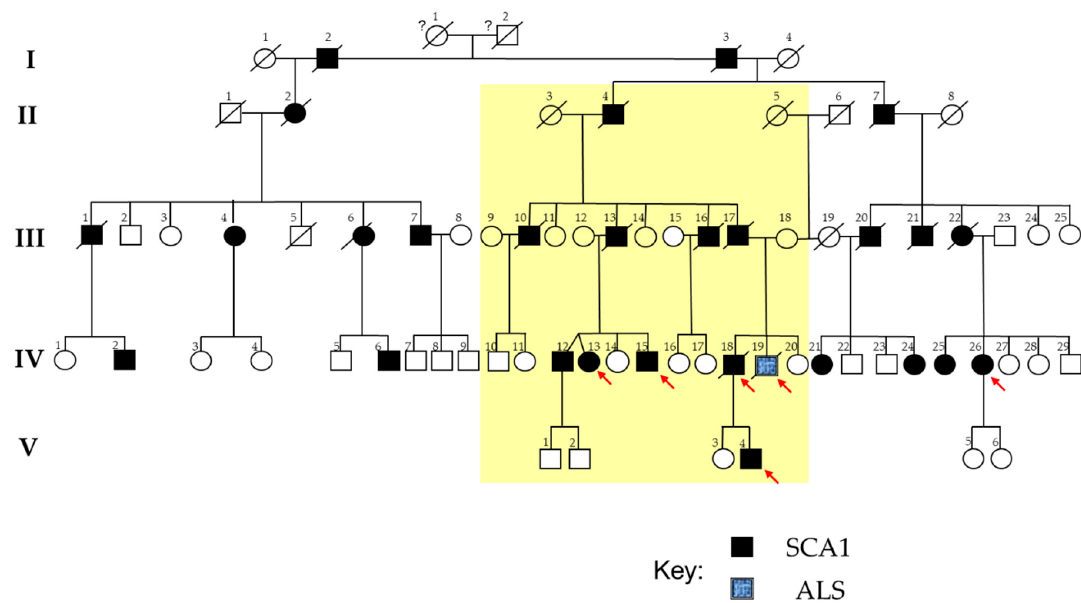
Figure 1. SCA1-ALS family pedigree. Square indicates male; circle female; slash deceased; black symbols indicate patients affected by SCA1; blue symbol indicates the patient affected by amyotrophic lateral sclerosis (ALS). The red arrows indicate the patients in whom genomic analyses were performed. The “central branch” of the genealogical tree, presenting patients showing ataxic-spastic phenotype with lower motor neuron (MN) signs or symptoms is highlighted in yellow.